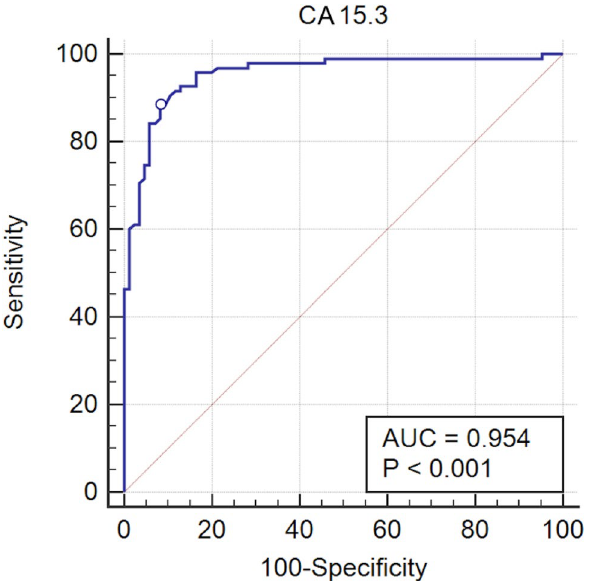
Figure 4. Receiver operating characteristic (ROC) analysis of sFlt-1 serum levels between severe and non- severe SARS-CoV-2 infected patients; the circle indicates the cut-off point (24.8 U/mL) with 88.4% Sensitivity and 91.8% Specificity for positive patients. AUC denotes area under the curve.